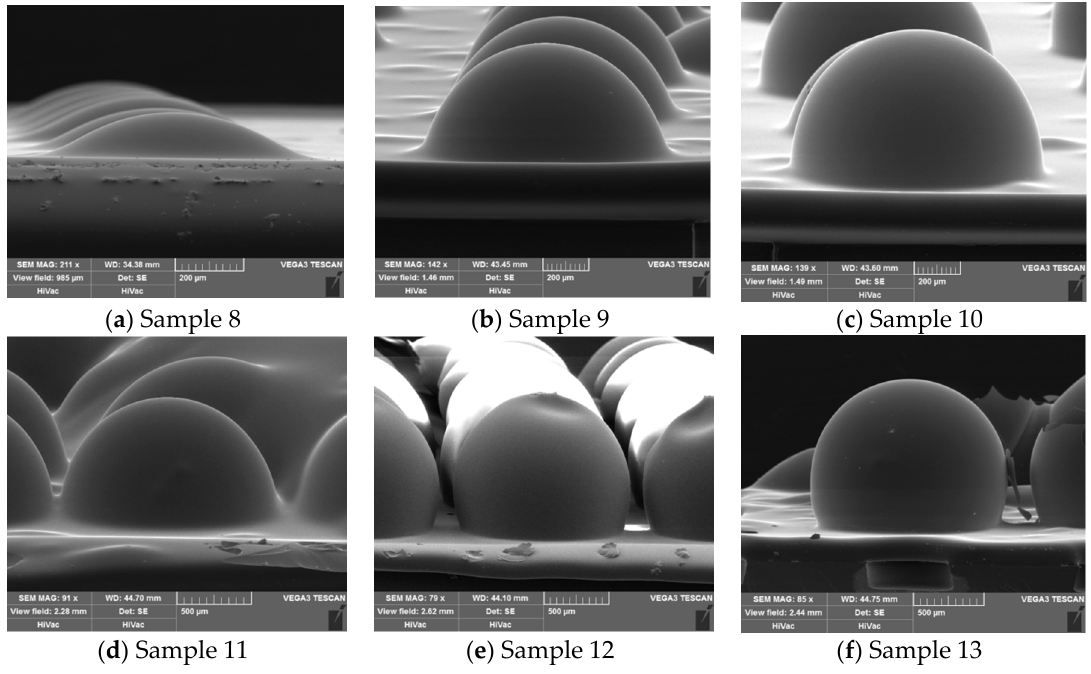
Figure 6. SEM images of the glass shell samples blown by 200 μ m deep etched cavities.